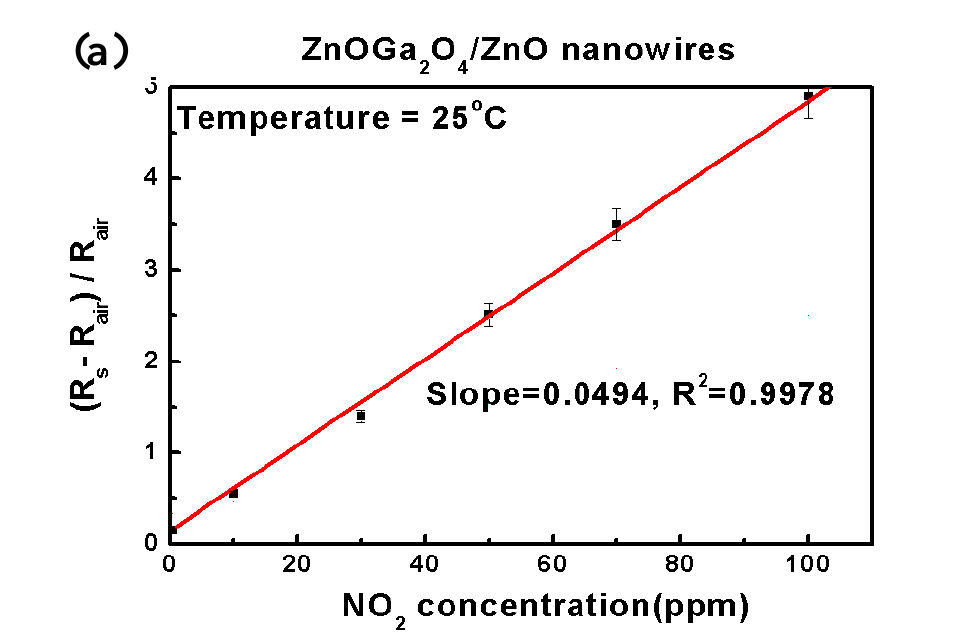
O /ZnO core-shell nanowire sensor and (b) 2 4 concentrations at 25 2